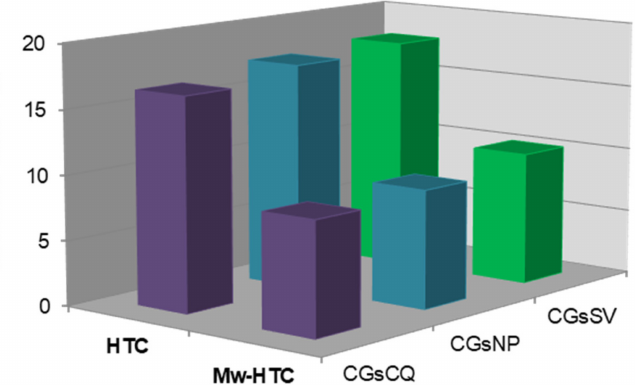
Figure 7. Comparative chart of photoluminescence of C-dots prepared under the HTC and Mw- HTC methods using various sources of CGs (HTC: 250 ◦ C, 6 h; Mw-HTC: 190 ◦ C, 3 h; mass ratio ED/CGs =